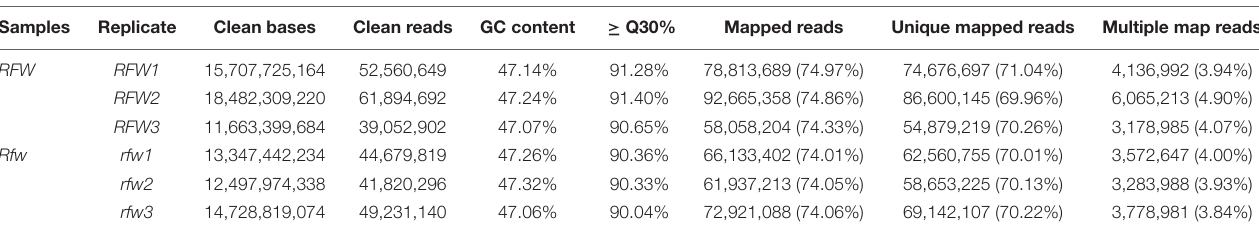
FIGURE 5 | Mitochondrial gene transcriptional levels in fertile and sterile buds (0–2 mm) based on RT-qPCR. The x -axis shows the 32 known protein-coding genes from B. juncea mitochondrial genomes (NCBI accession nos. KJ461445 and JF920288). Bna.Actin7 was used as the internal control. Error bars indicate standard deviation ( n = 3). * P < 0.05. TABLE 1 | Sequencing and mapped reads